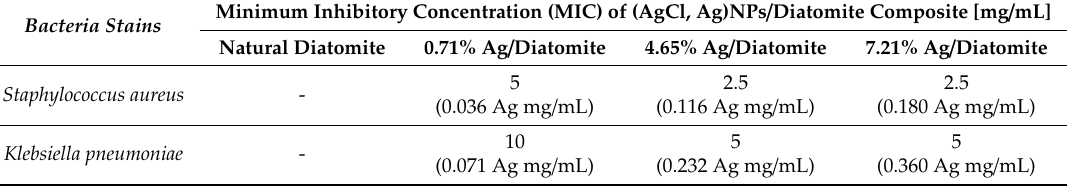
Table 3. Minimal inhibitory concentrations of (AgCl, Ag)NPs / diatomite